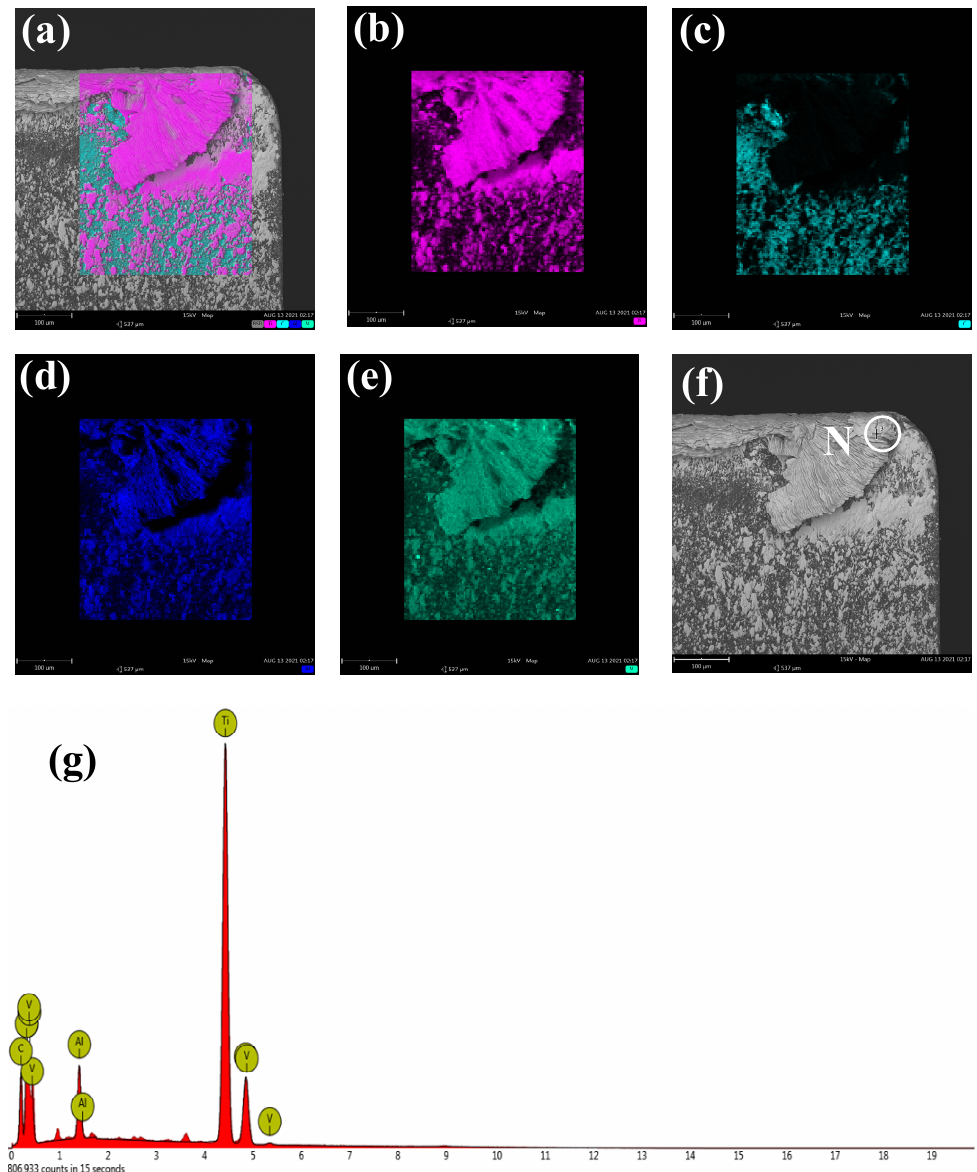
Figure 7. Element distribution and EDS of rake face in ultrasonic-assisted milling: ( a ) combined map; ( b ) titanium; ( c ) carbon; ( d ) aluminum; ( e ) vanadium; ( f ) rake face; ( g ) EDS analysis of point N.